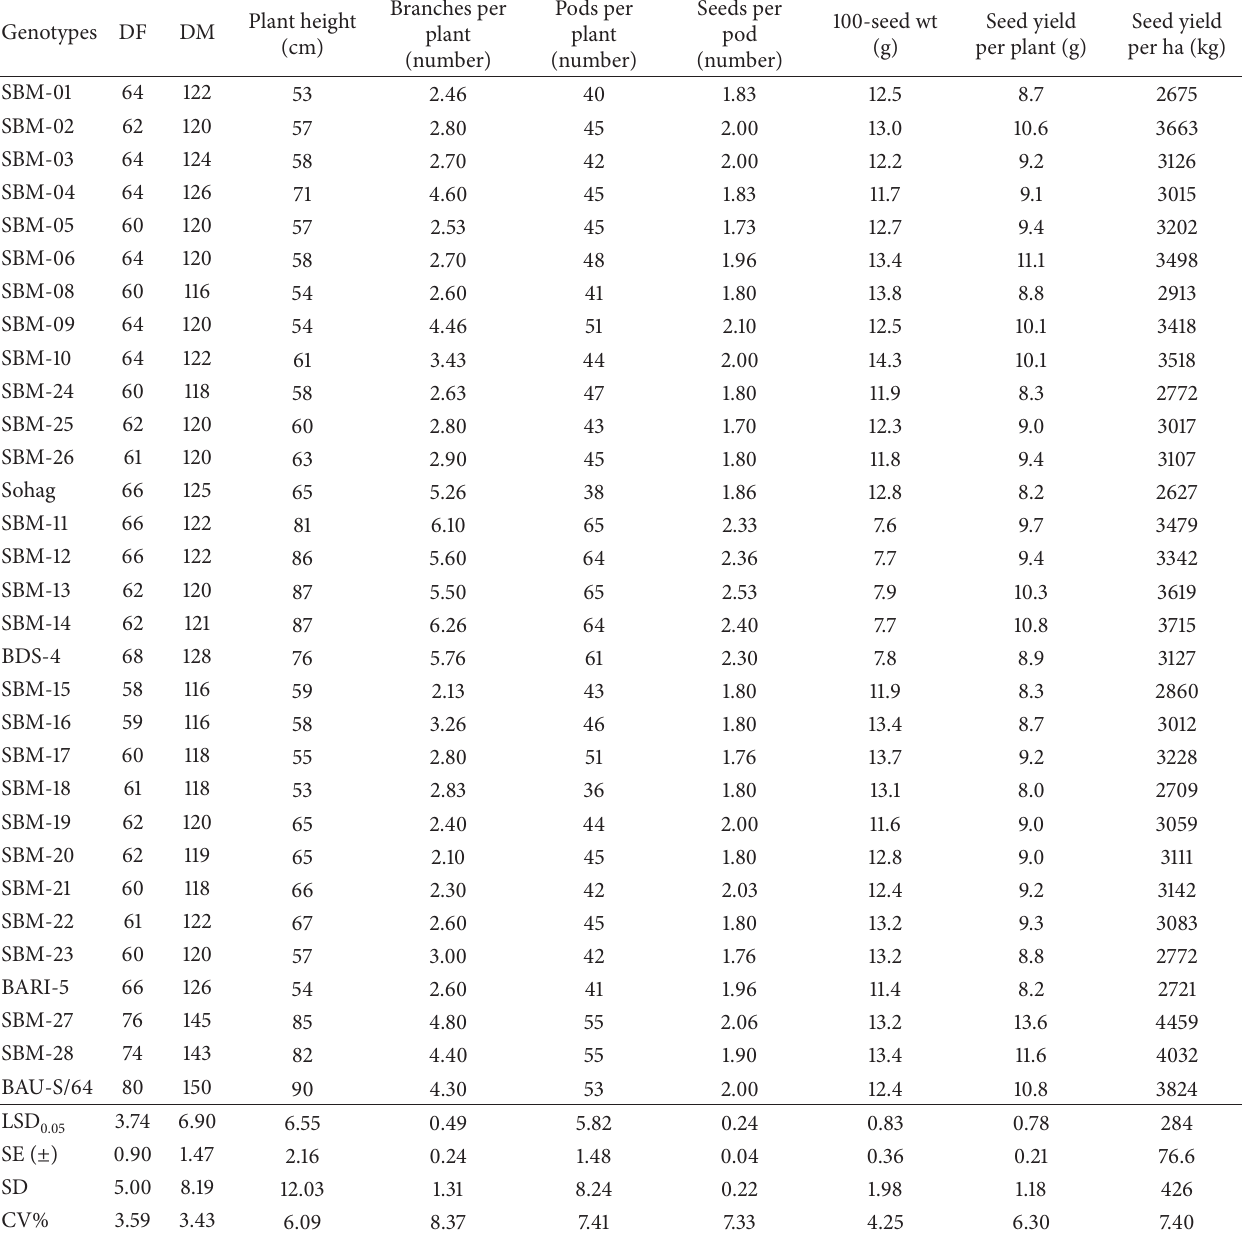
Table 5: Mean performances of 27 soybean mutants and four mother varieties for nine different phenological and morphological characters, yield attributes, and seed